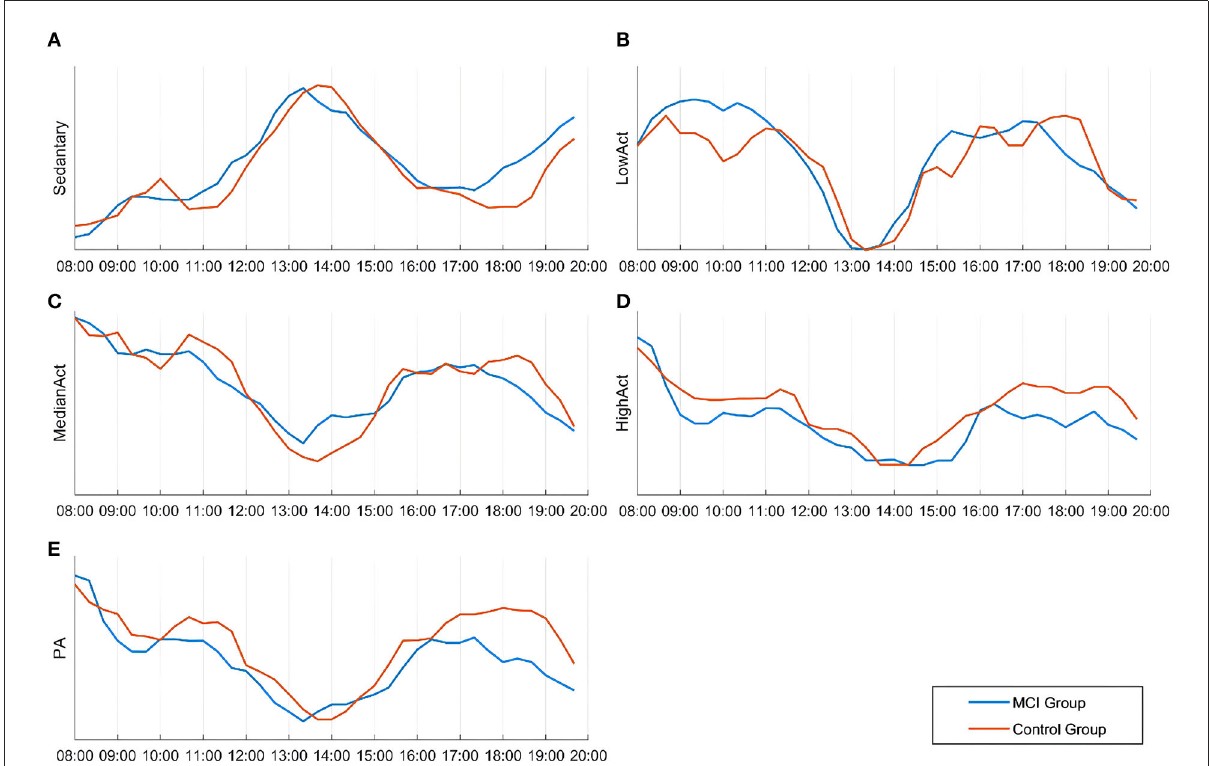
FIGURE2 Differences in the temporal distribution of activity intensity and the amount of activity in various states between the two groups during 08:00–20:00. (A) Sedentary state; (B) Low physical activity state; (C) Median physical activity state; (D) High physical activity state; (E) Physical activity.